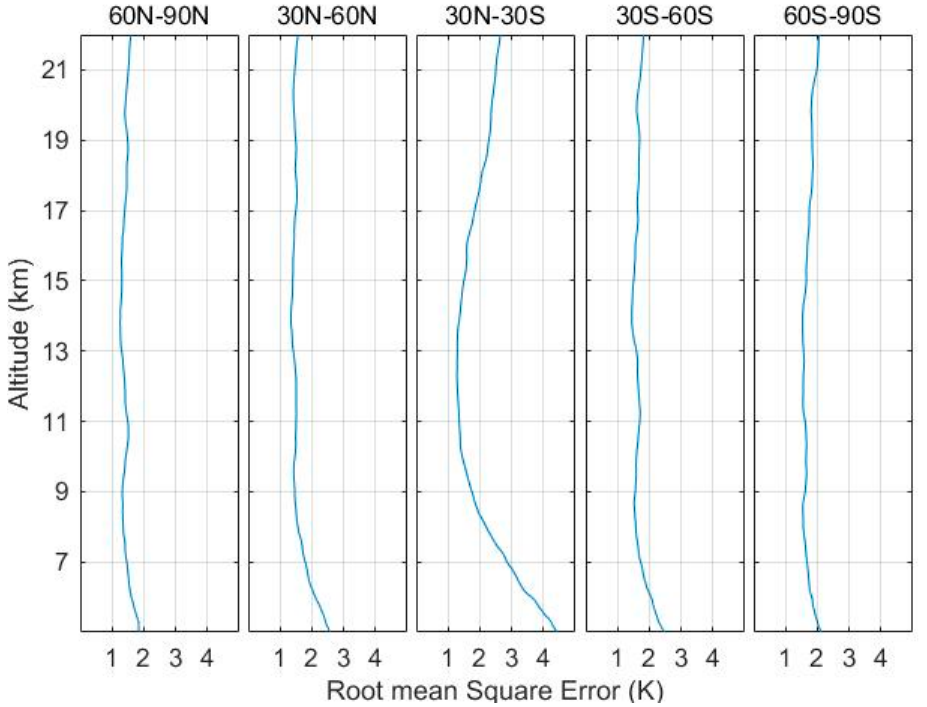
ff erent latitude